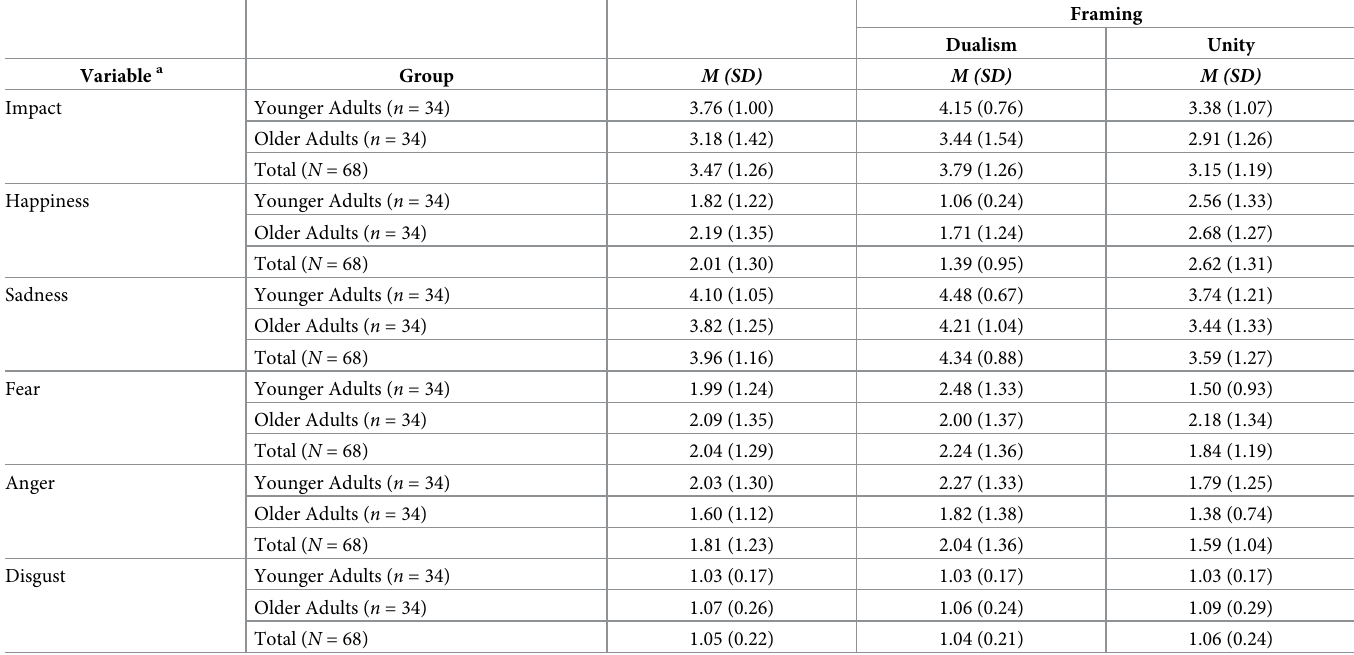
Table 3. Descriptive statistics on impact and emotions